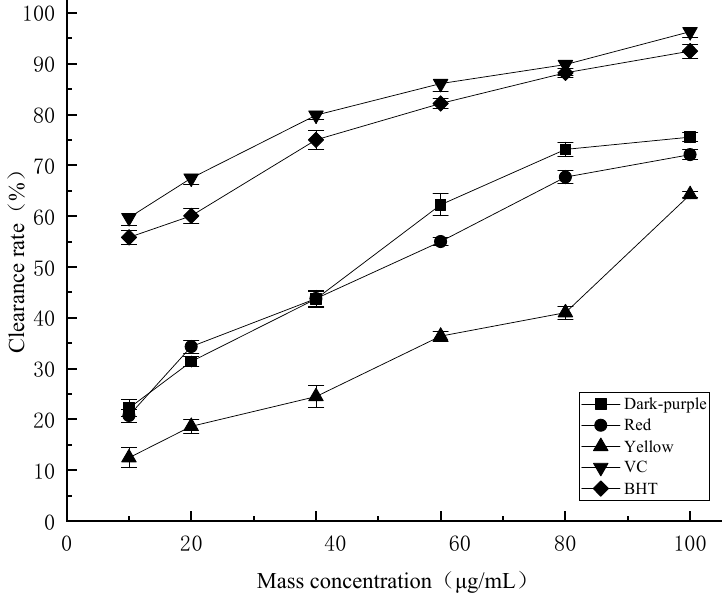
Figure 5. Comparison of the ABTS radical scavenging activity of essential oil for different colors of P. delavayi flowers.